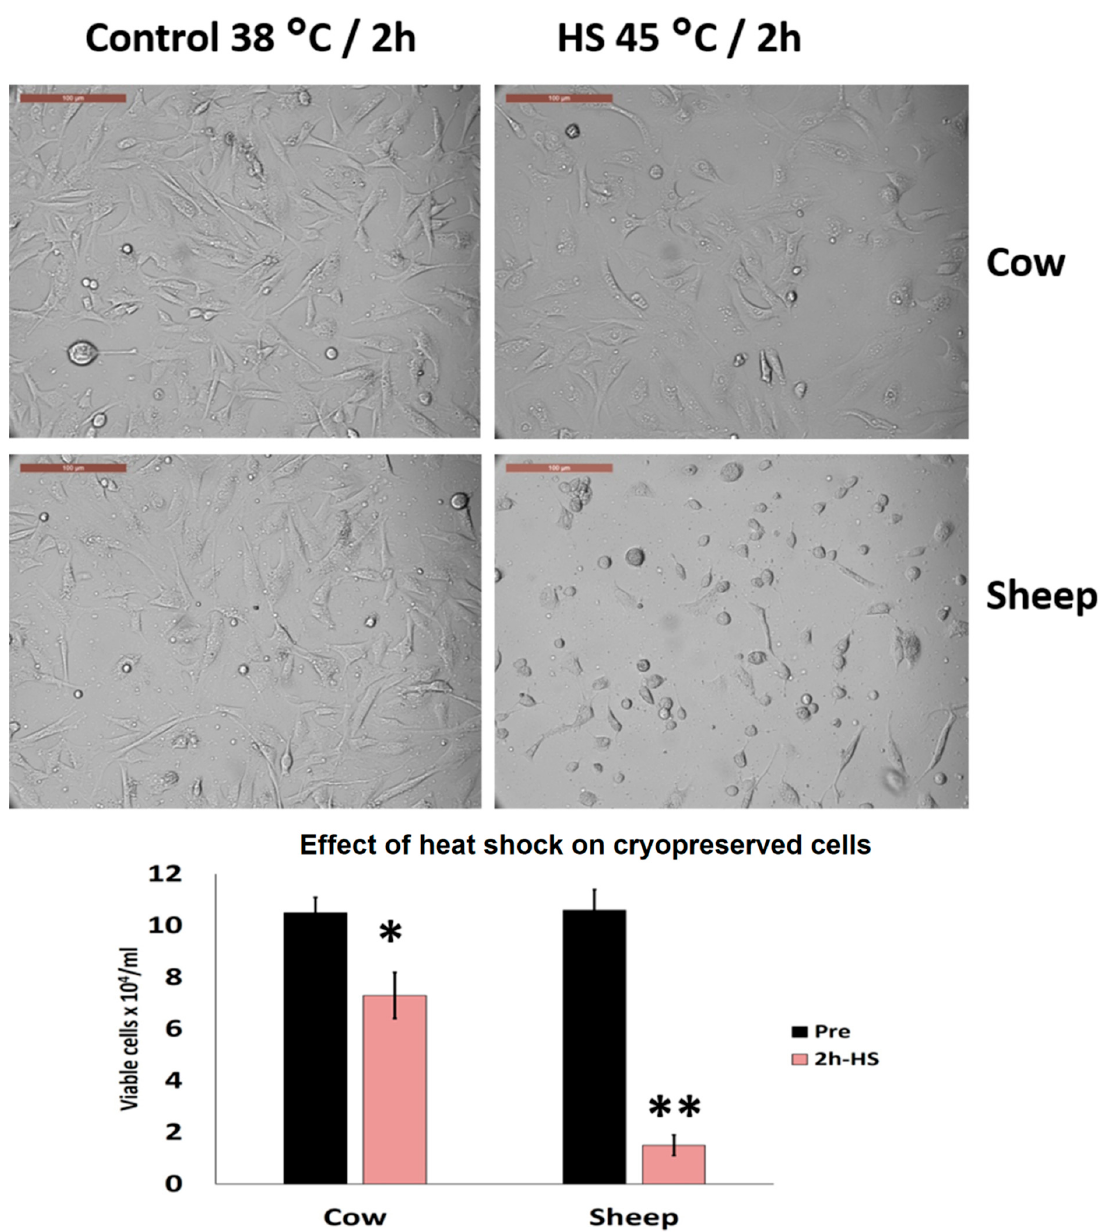
Figure 8. High magnification of cow and sheep cryopreserved fibroblasts after exposure to acute heat shock (4 °C for 2 h). In cow cells, several cells remained attached to the cell culture dish and retained a spindle morphology (arrows), whereas, in sheep, the majority of the cells lost their architecture (arrows) and attachment to the culture dish. The numbers of attached and non-attached cells were counted and analyzed with ImageJ software and the data were analyzed by Student’s t -test. Scale bar = 100 µm. The graph describes the effects on cell viability, data are presented as means ± SEM, values of the same timings were analyzed using a Student’s t -test, and asterisks (*) and (**) indicate significant changes at p < 0.05 and p < 0.01, respectively.